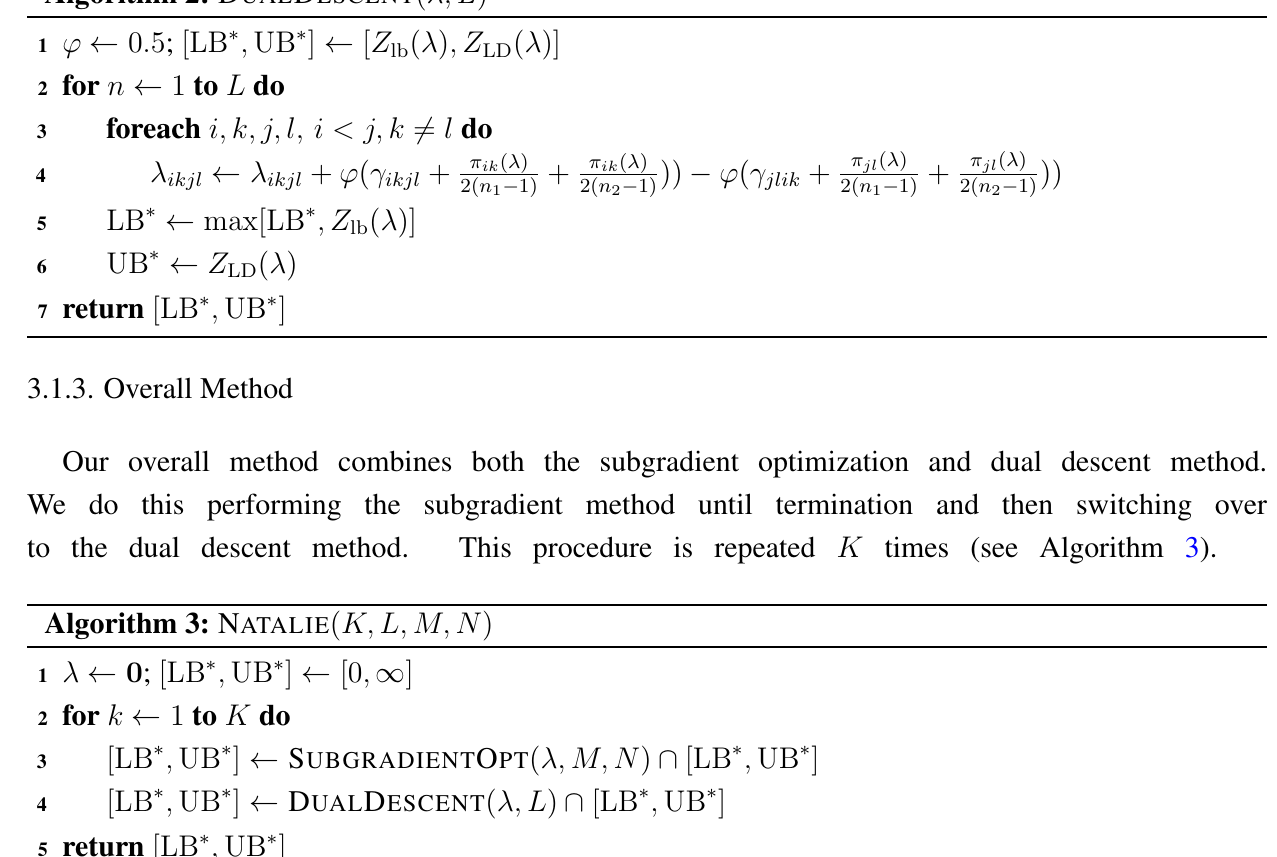
Algorithm 2: D UAL D ESCENT ( λ, L )